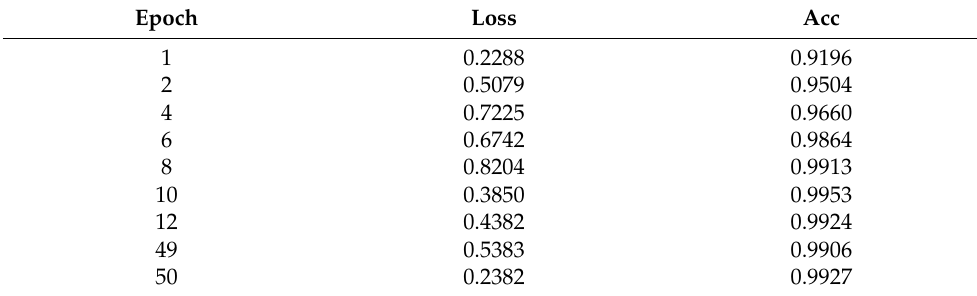
Table 2. Loss and Acc results for function values training and validation data on the ResUNet model for Tumor Segmentation using a different number of epochs.